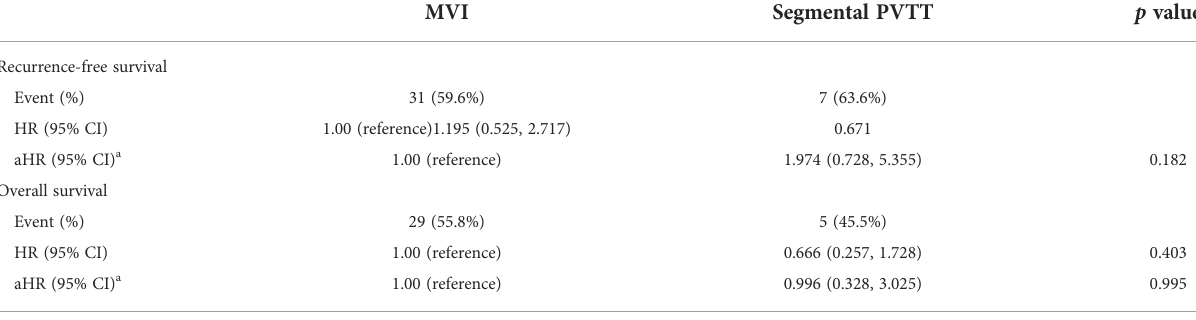
TABLE 4 Association of MVI and segmental PVTT with recurrence-free survival and overall survival among patients with HCC who underwent DDLT. MVI